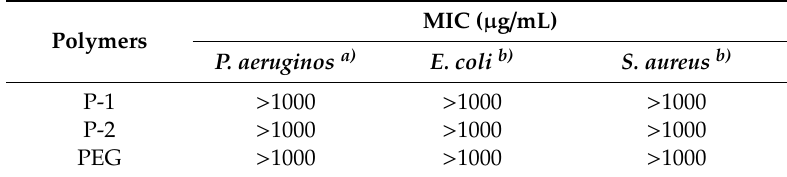
Table 2. Antimicrobial activity of P-1, P-2, and PEG.